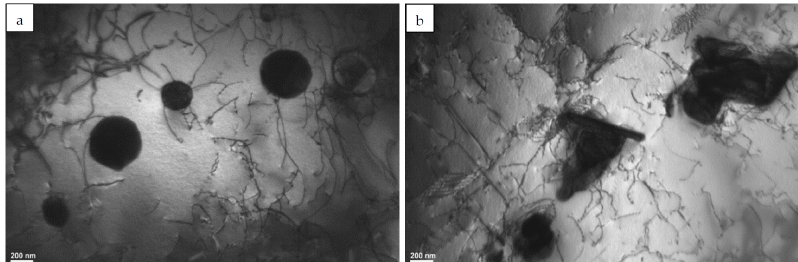
Figure 2. T ransmission electron microscopy (TEM) images of precipitates in the as-built L-DED Inconel 625 with: ( a ) globular and spherical morphology, as well as ( b ) merged particles with irregular and/or plate-like